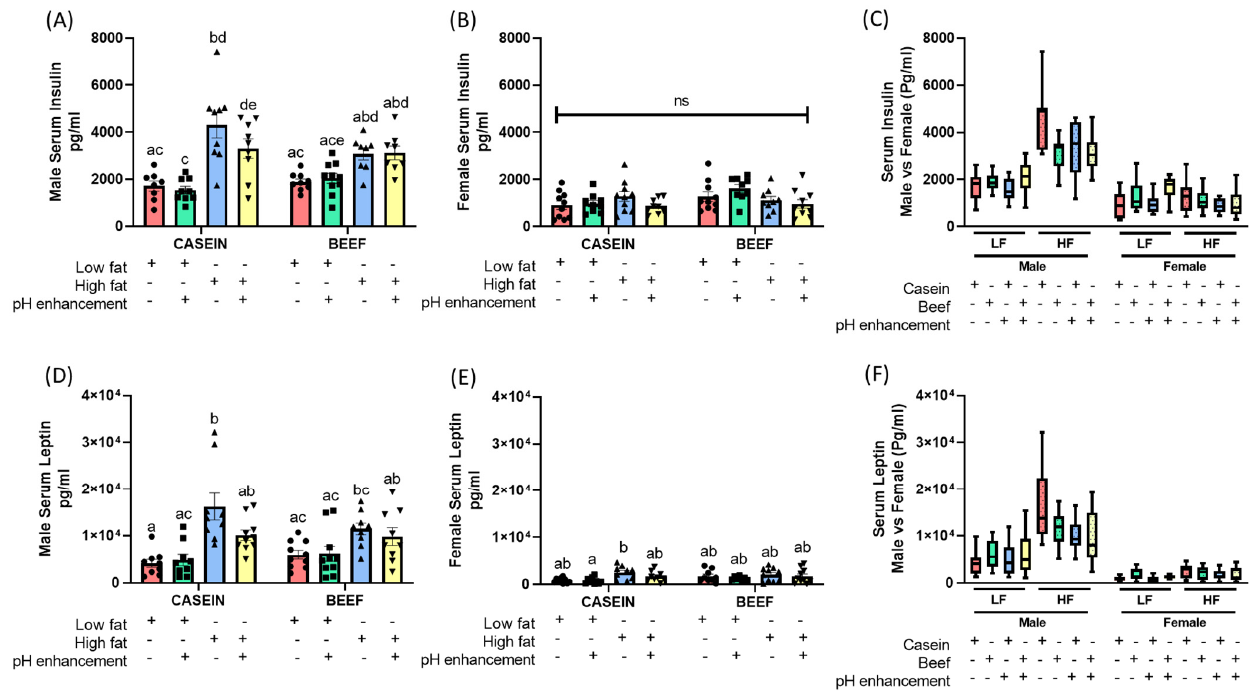
Figure 6. Effects of diet, protein source, pH enhancement and sex on serum metabolic markers in male and female mice. ( A ) Serum insulin levels in male mice. ( B ) Serum insulin levels in female mice. ( C ) Serum insulin levels in male vs. female mice. ( D ) Serum leptin in male mice. ( E ) Serum leptin in female mice. ( F ) Serum leptin levels in male vs. female mice. Data is presented as mean ± SEM. LFC, low fat casein; LFCN, low fat casein pH enhanced; LFB, low fat beef; LFBN, low fat beef pH enhanced; HFC, high fat casein; HFCN, high fat casein pH enhanced; HFB, high fat beef; HFBN, high fat beef pH enhanced. Common letters on the error bars indicate no significance (e.g., “a” is significantly different from “b”, and “ab” indicates no significance compared to “a” and “b”). p < 0.05; n = 8–10.